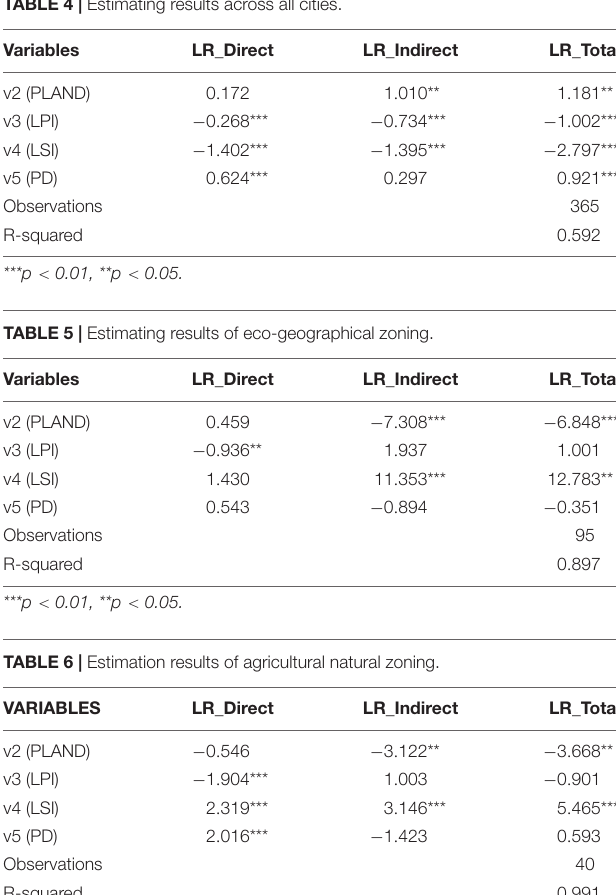
TABLE 4 | Estimating results across all cities.